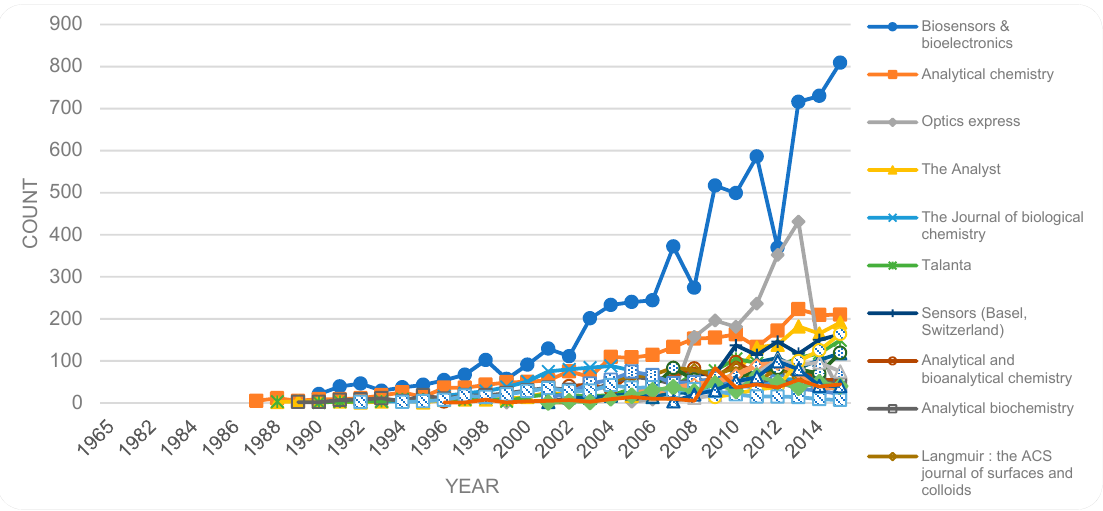
Figure 13. Journal Titles (top 20) by year.